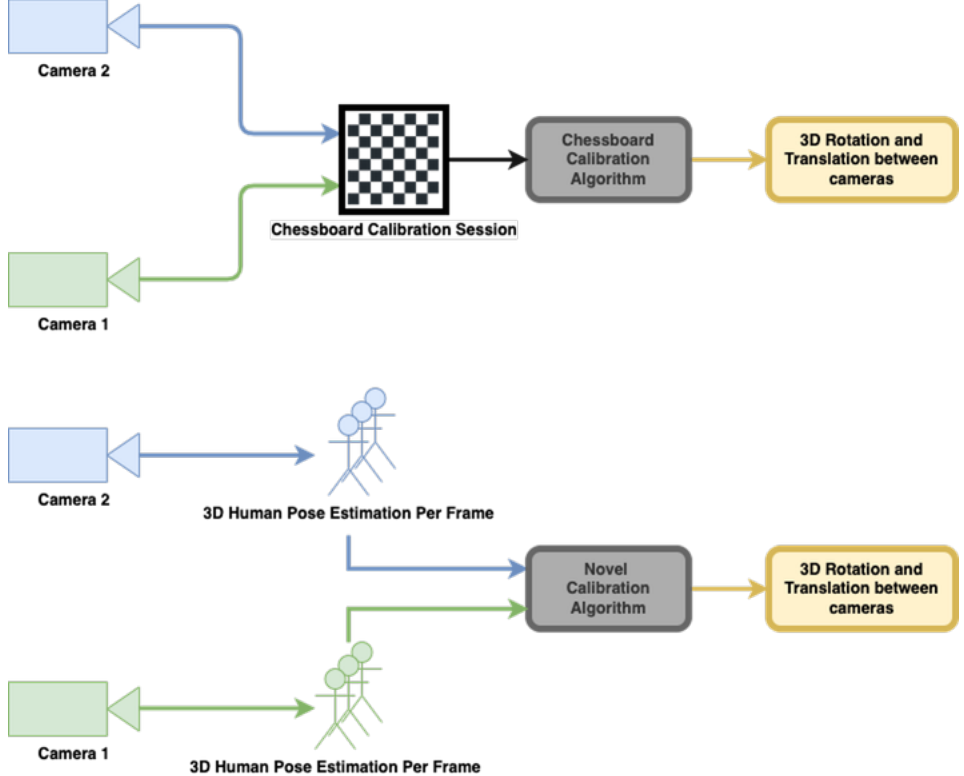
Figure 12. Comparing calibration methods: manual calibration using checkerboard ( top ) vs. our human-motion based calibration method ( bottom